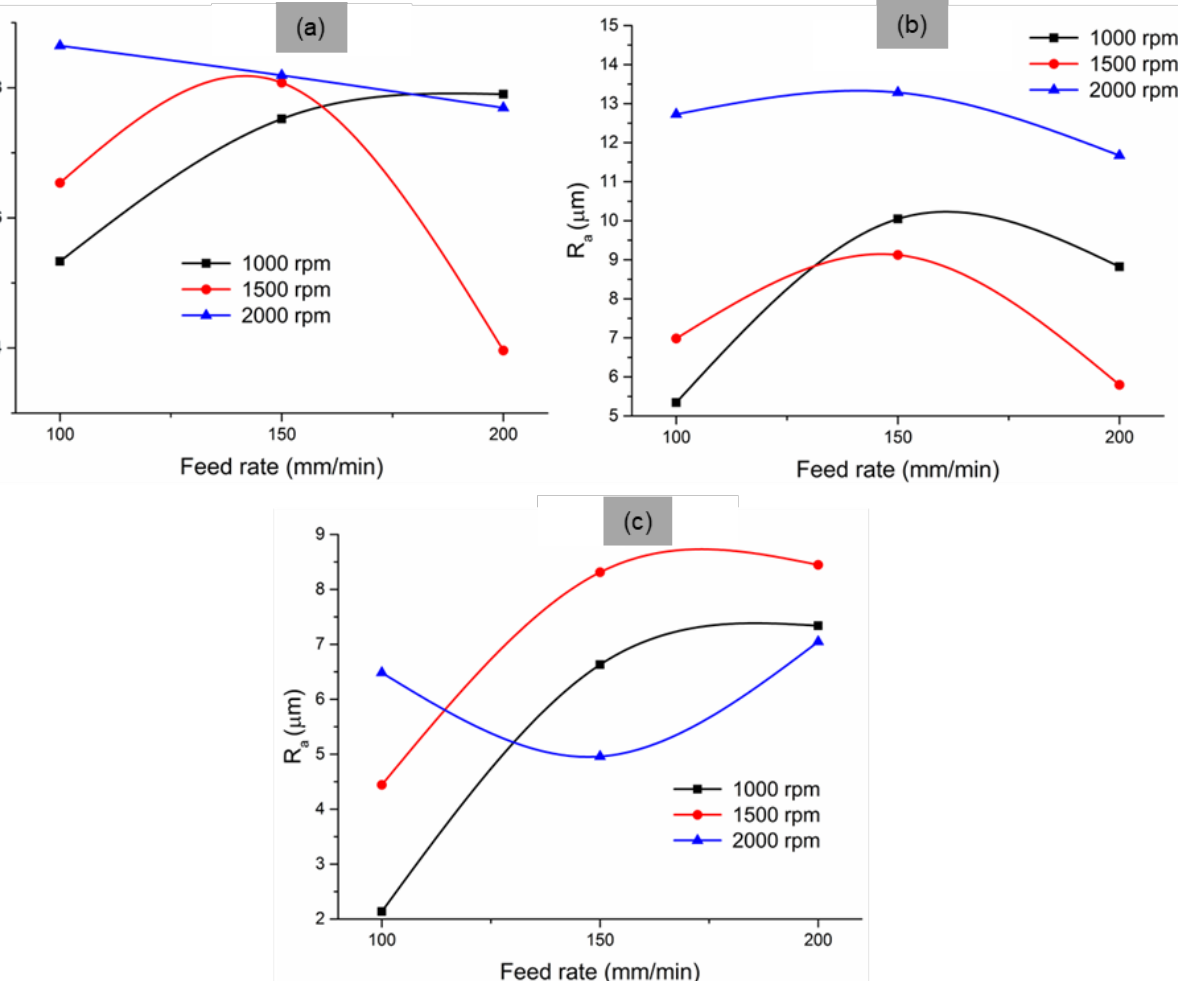
Figure 6. The variation in surface roughness on redmud-filled sisal composite structures at different point angles: ( a ) 90°, ( b ) 118°, and ( c ) 135°.